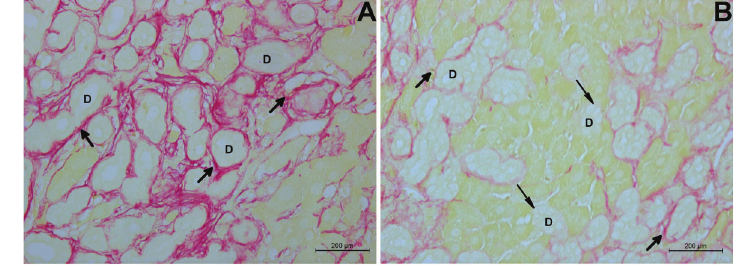
Figure 7. Representative microphotographs of liver with biliary fi brosis in the experimental groups, BDL ( A ) and BDL + AM ( B ), 9 weeks after fi brosis induction. D: biliary structures; thick arrows: collagen fi bers in the periductular region; thin arrows: absence of collagen fi bers in the periductular region. Sirius Red staining, magni fi - cation 400 (cid:1) . BDL: bile duct ligation; AM: amniotic